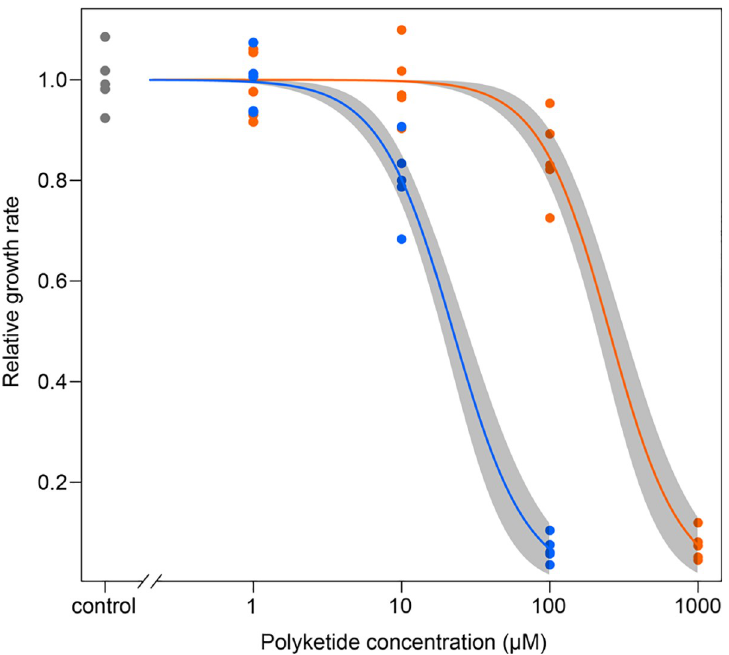
Fig 5. Effects of a 48-h exposure of S . cerevisiae cells to diaphorin or pederin. Dose-response curves relating polyketide concentrations (x-axis) to the relative growth rates of S . cerevisiae (y-axis). All data points (diaphorin: orange; pederin: blue; control: grey) of five repeated experiments are presented together with the lines corresponding to the fitted two-parameter log-logistic model analyzed with the statistical computing software R and its add-on package drc. Shaded bands represent 95% confidence intervals of the model.